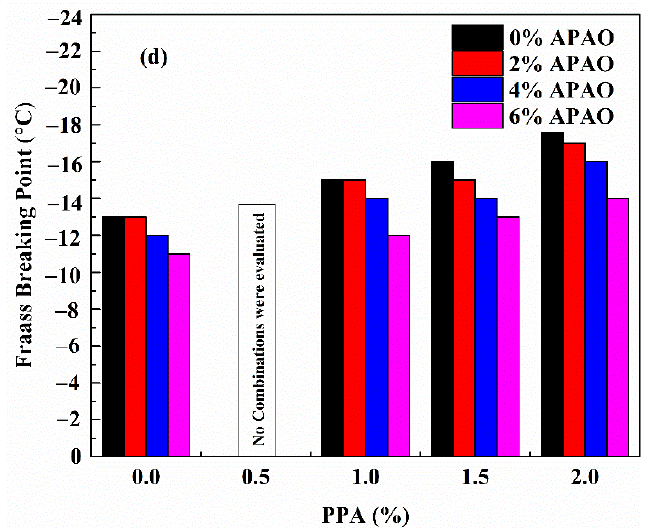
Figure 2. Conventional properties of all specimens: ( a ) penetration; ( b ) softening point; ( c ) ductility; ( d ) Fraass breaking point.